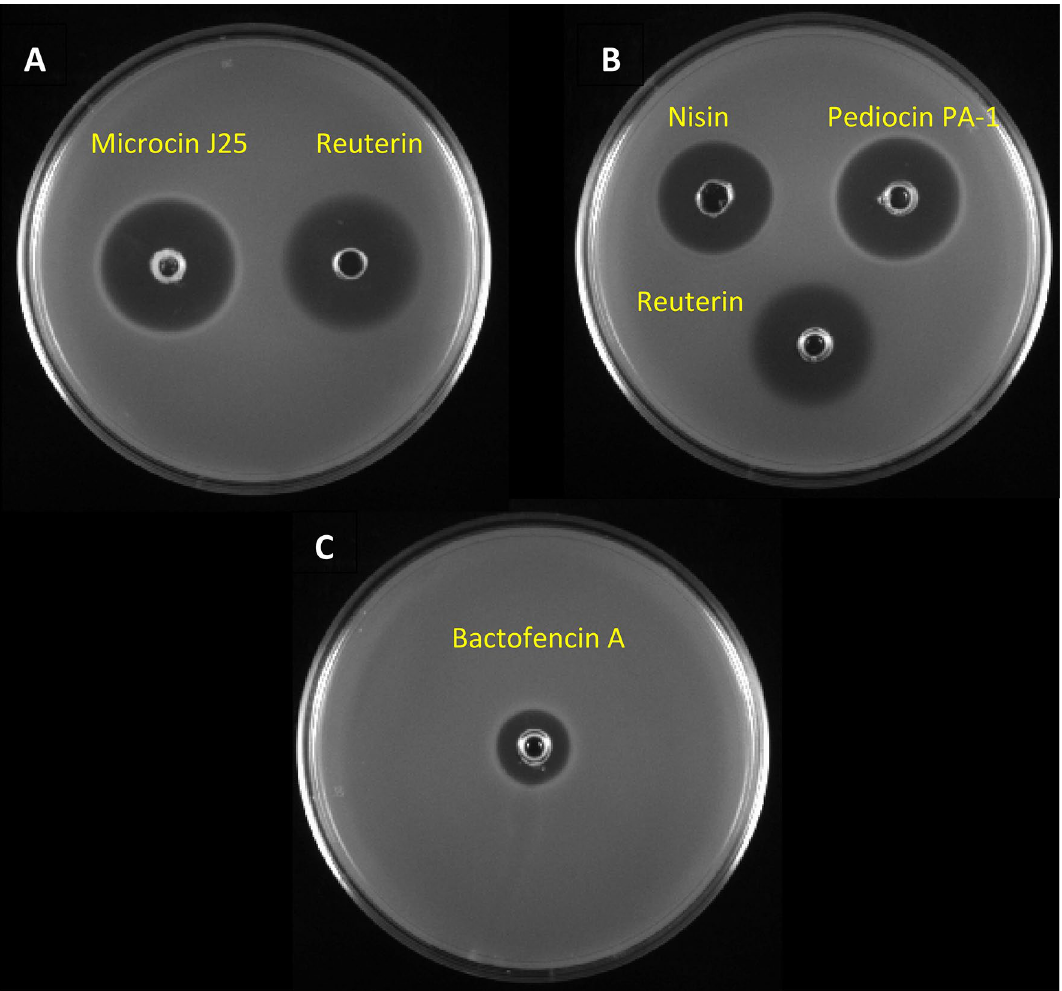
Figure 2. Inhibitory activity of bacteriocins and reuterin. ( A ) Microcin J25, 200 µg/mL, and reuterin 20 mg/mL against S . Newport ATCC 6962. ( B ) Pediocin PA-1 200 µg/mL and nisin Z 400 µg/mL, and reuterin 20 mg/mL against L. ivanovii HPB28. ( C ) Bactofencin A 500 µg/mL against S. aureus ATCC